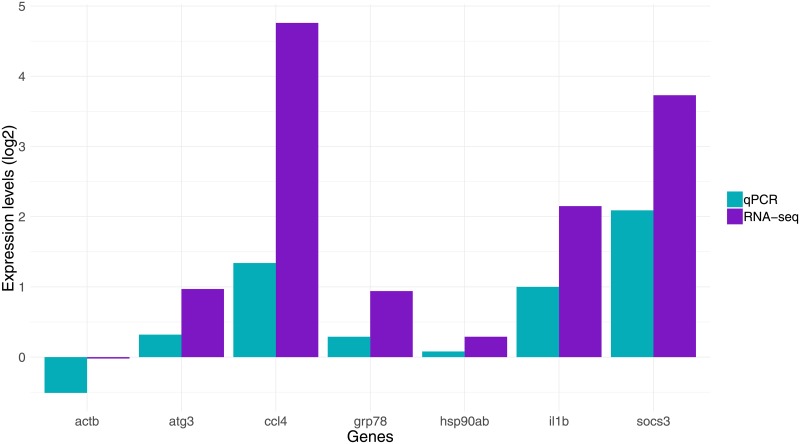
Comparison of qPCR and RNA-seq.Bar plot showing similar pattern of down/upregulation for tested genes on both analyses. Fold change values are represented in log2 scale from both RNA-seq and qPCR. 18s and ef1a were used as reference genes to calculate gene expression levels for qPCR data from three biological and two technical replicates.